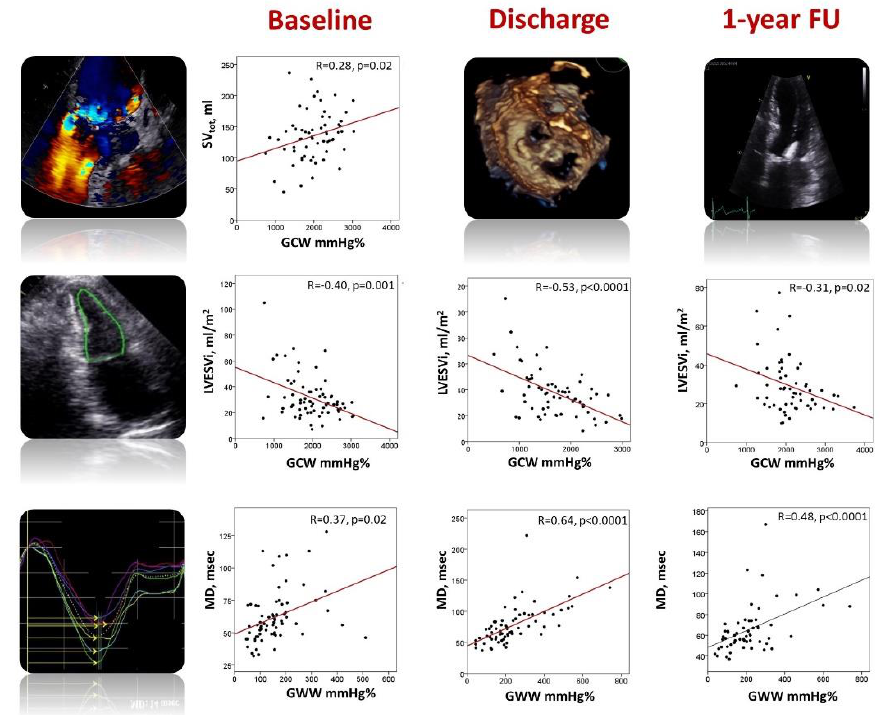
Figure 2. Relationship between myocardial work parameters, left ventricular total stroke volume, end-systolic volume, and mechanical dispersion before TEER ( left panels ), at hospital discharge ( central panels ) and 1-year follow-up ( right panels ). GCW, global constructive work; GWW, global wasted work; LVESVi, indexed left ventricular end-systolic volume; MD, mechanical dispersion; SVtot, total stroke volume. Table 2. Main correlates of myocardial work indices at baseline, hospital discharge, and 1-year fol- low-up.